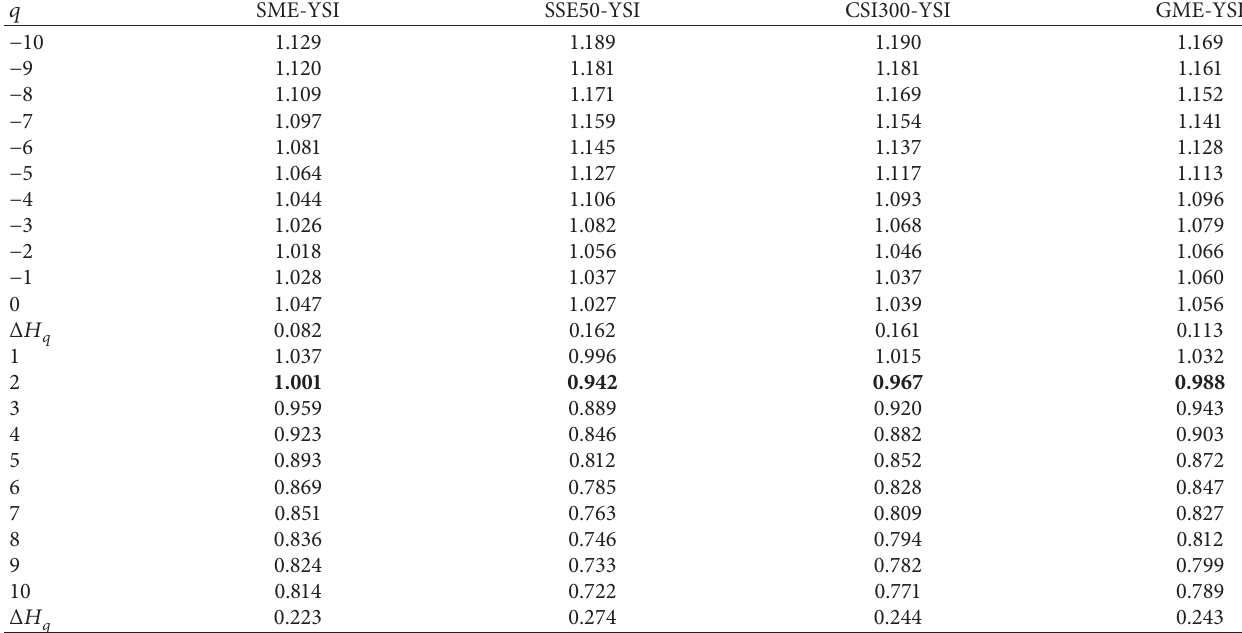
Table 6: Results of the MF-DCCA scaling exponent for Chinese stock market returns volatility. q